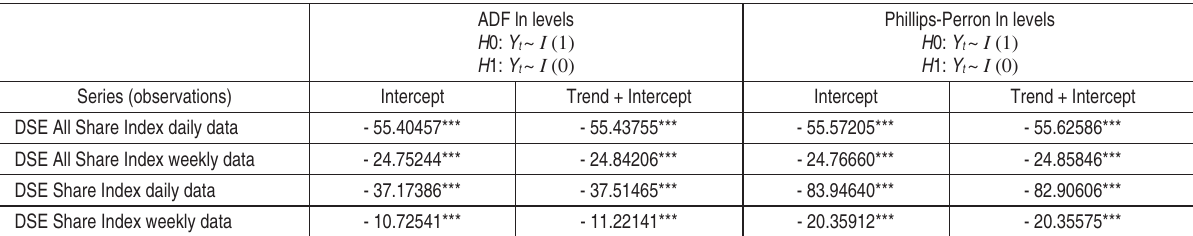
Table 3. Results of stationarity tests